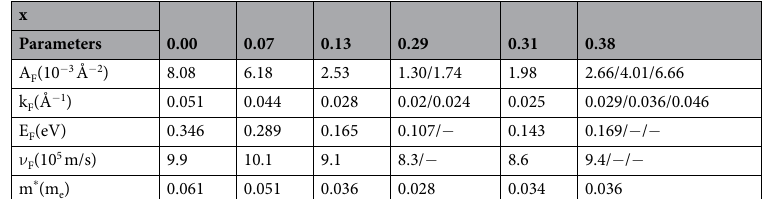
Table 1. Parameters of the tested samples of different zinc concentration x. The dashed entries mean quantities missing.